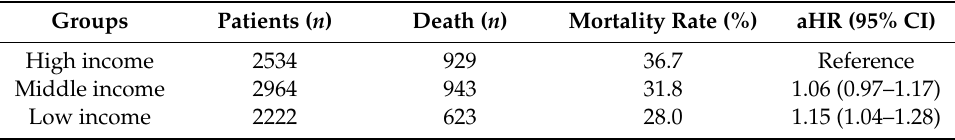
Table 2. Results of Cox Regression Analysis for Insured Employees Patients.